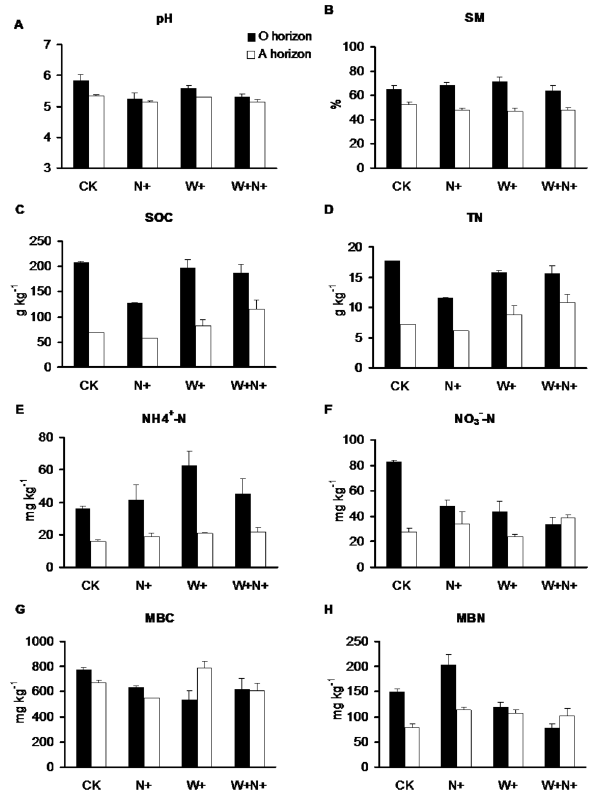
Figure 1. The effects of water addition, N addition and their interaction on soil properties. Bars indicate standard errors. SM, soil moisture; SOC, total soil organic carbon; TN, total nitrogen; MBC, microbial biomass carbon; and MBN, microbial biomass nitrogen.